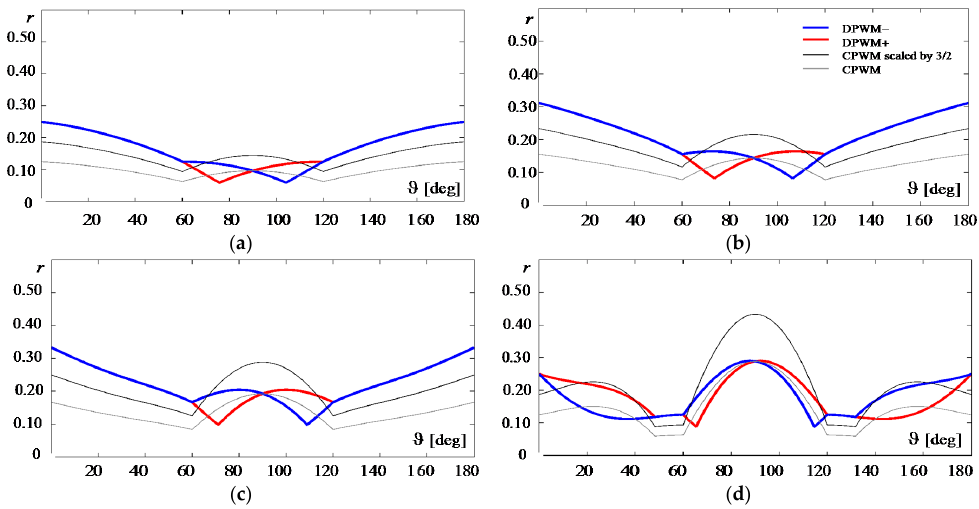
Figure 15. Normalized peak ‐ to ‐ peak current ripple amplitude r ( m , ϑ ) over the range ϑ = [0, 180°] in case of DPWM − (blue trace), DPWM+ (red trace), centered pulse ‐ width modulation (CPWM) (grey trace) and CPWM scaled by 3/2 (black trace), for different modulation indexes: ( a ) m = 1/6; ( b ) m = 1/4; ( c ) m = 1/3; and ( d ) m = 1/2.